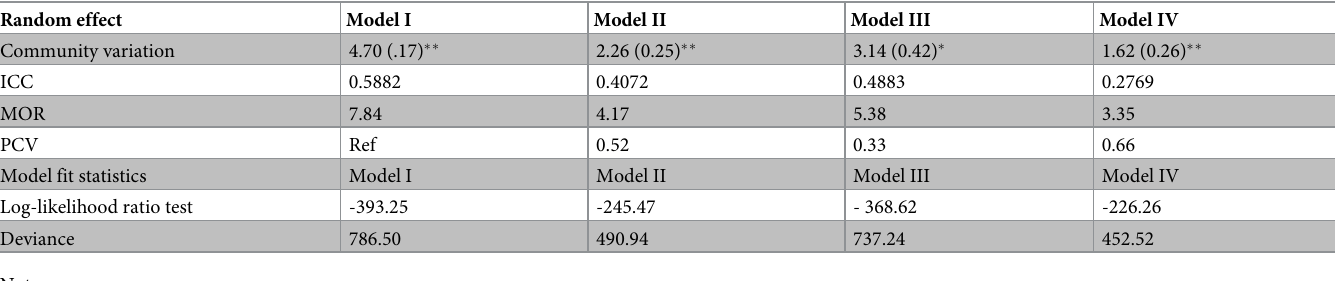
Table 3. Model comparison and goodness of fit test in the multilevel